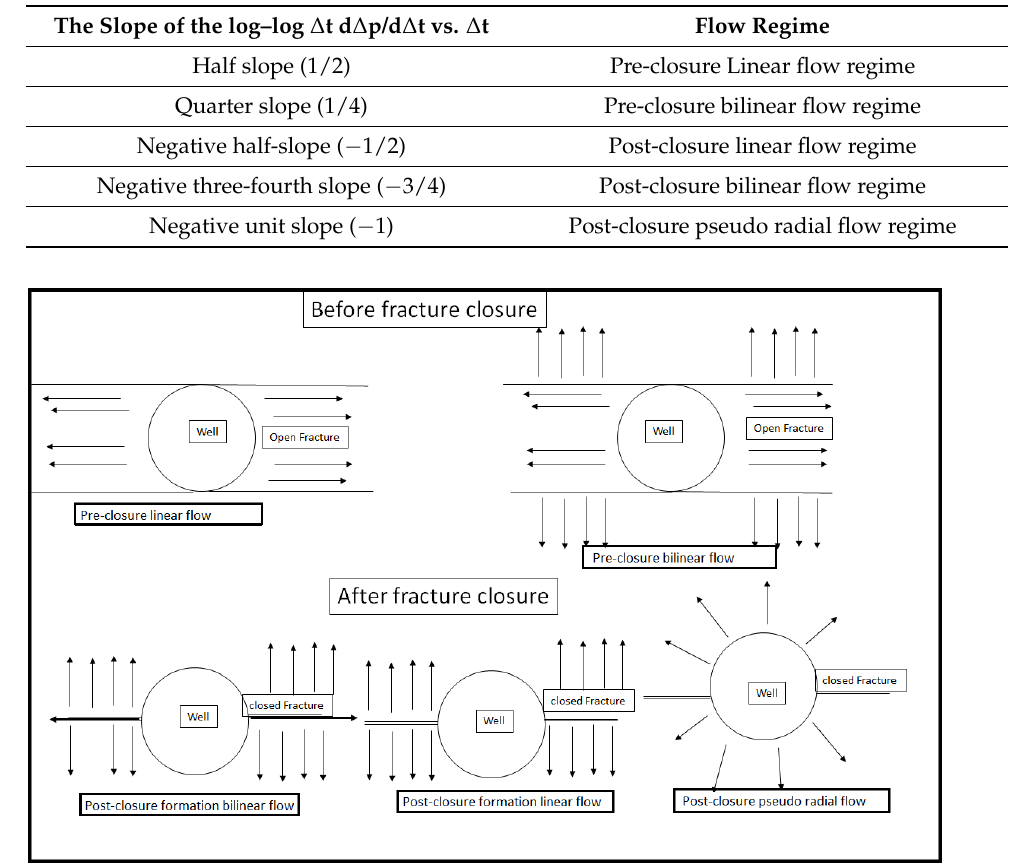
Figure 15. Transient flow regimes before and after fracture